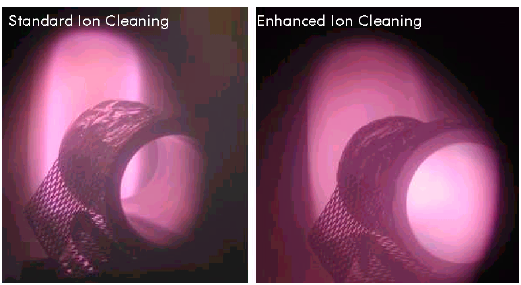
Figure 3. Photo shots (Gencoa, https://www.gencoa.com/) of cylinder liners in front of a Cr target